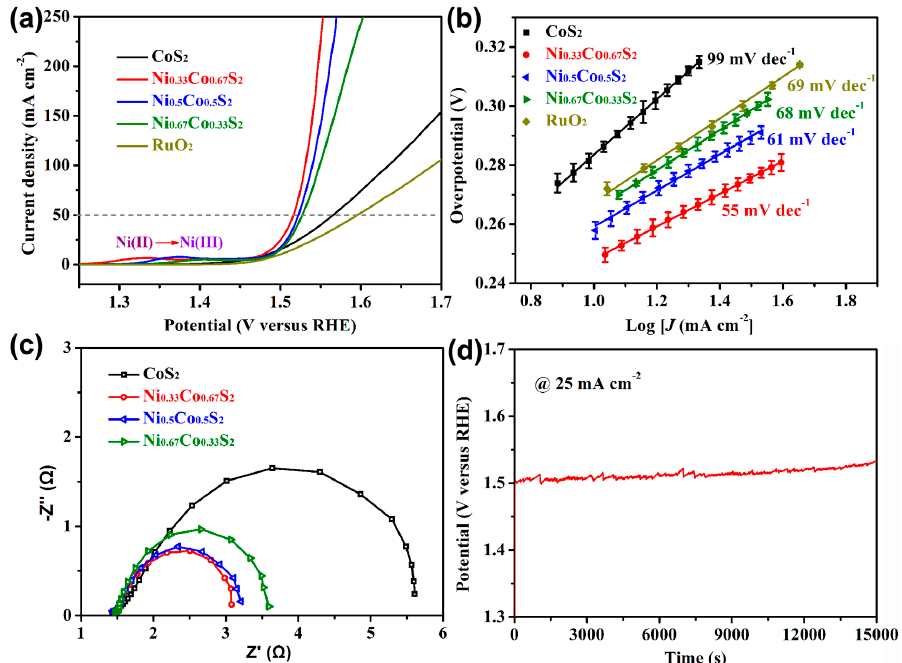
Figure 5. ( a ) Oxygen evolution reaction (OER) performance of commercial RuO 2 , bare CoS 2 and Ni ‐ doped CoS 2 nanoneedle arrays on SS in 1.0 M KOH. The scan rate is 5 mV s − 1 ; ( b ) Corresponding Tafel plots. The error bar stands for the results, ranging from three independent repeated measurements; ( c ) Nyquist plots of the four catalysts at an overpotential of 300 mV; ( d ) Chronopotentiometric response of Ni 0.33 Co 0.67 S 2 NN/SS at a constant anodic current density of 25 mA cm − 2 . Besides the catalytic activity, the Ni 0.33 Co 0.67 S 2 NN rooted on SS substrate also presented